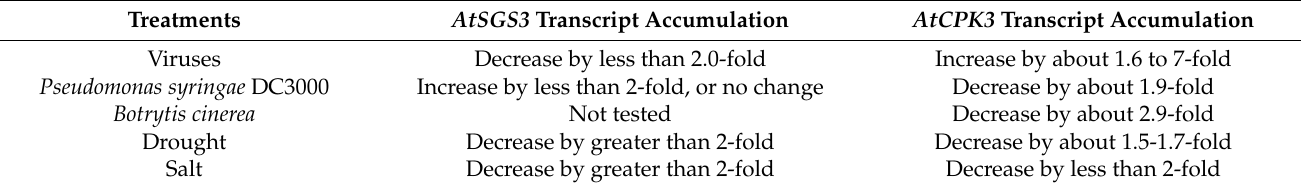
Table 1. Transcript accumulation of AtSGS3 and AtCPK3 in response to viral, bacterial, fungal and abiotic stresses. Viruses tested were cauliflower mosaic virus (CaMV), tobacco mosaic virus (TMV), tomato spotted wilt virus (TSWV), turnip mosaic virus (TuMV) and turnip yellow mosaic virus